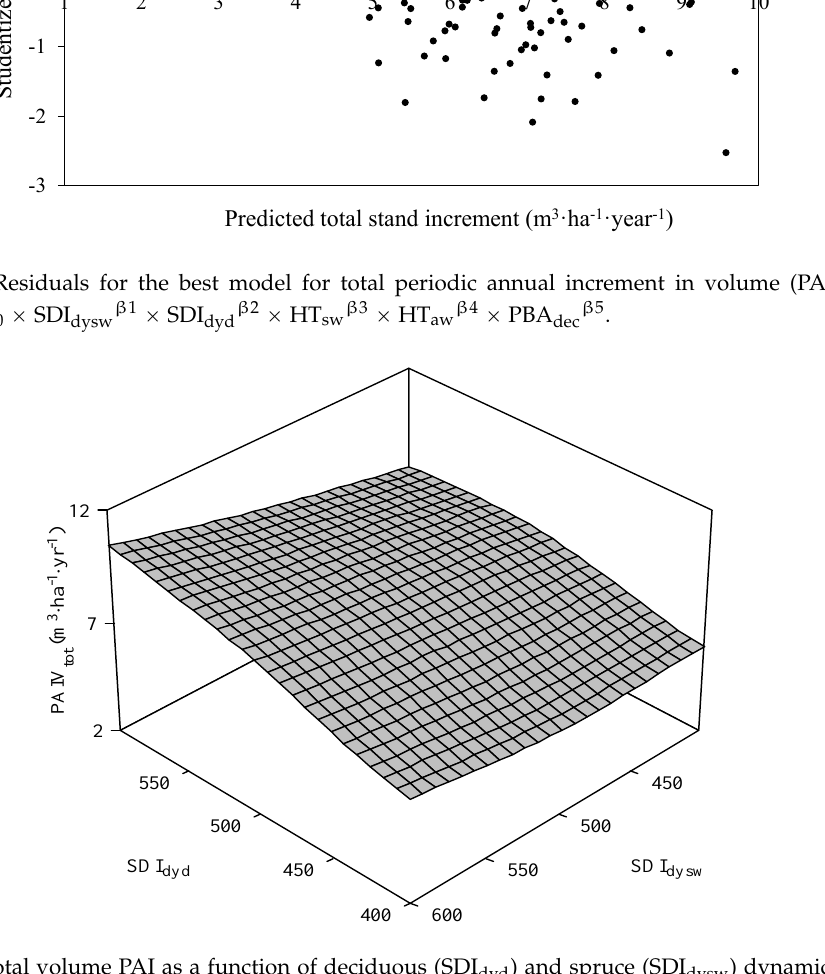
Figure 6. Total volume PAI as a function of deciduous (SDI dyd ) and spruce (SDI dysw ) dynamic SDI; (HT sw and HT aw held constant and PBA dec varying with changes in SDI dyd . Model: PAIV tot = 0.222 × SDI dysw−0.03 × SDI dyd0.99 × HT sw0.11 × HT aw0.31 × PBA dec−0.93 .